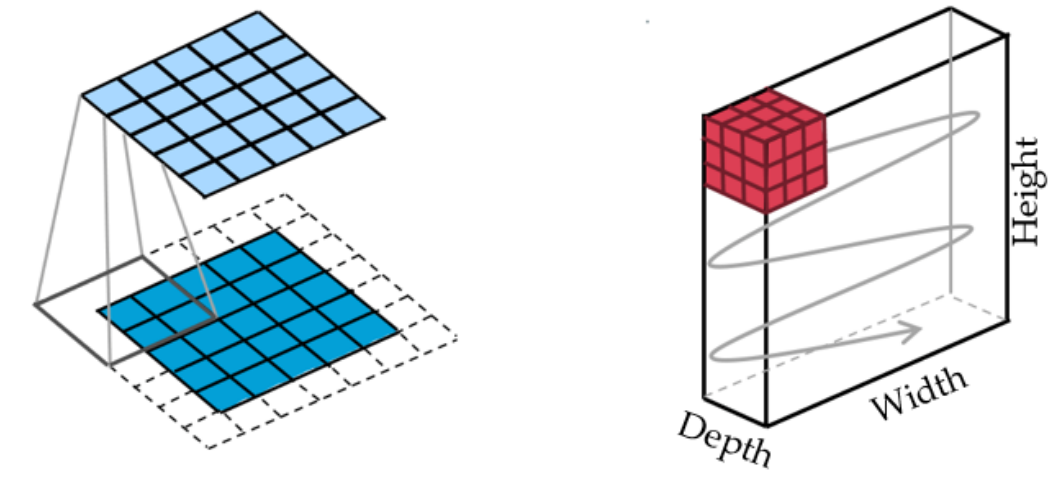
Figure 7. Convolutional layer and the kernel movement pattern [34].